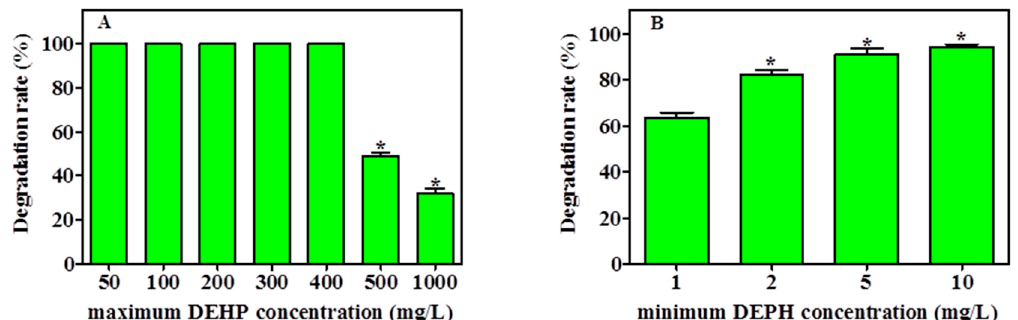
Figure 4 . Maximum ( A ) and minimum ( B ) degrading ability of DEHP by YC-IL1 strain after 7 days incubation. Data represent the mean ± SEM of three independent experiments. * indicates the significance difference ( p < 0.05; one-way ANOVA followed by Dunnett’s test) between the columns denoted with (*) and control; the controls are 100 mg/L for the maximum DEHP concentration ( A ) and 1 mg/L for the minimum DEHP concentration ( B ).